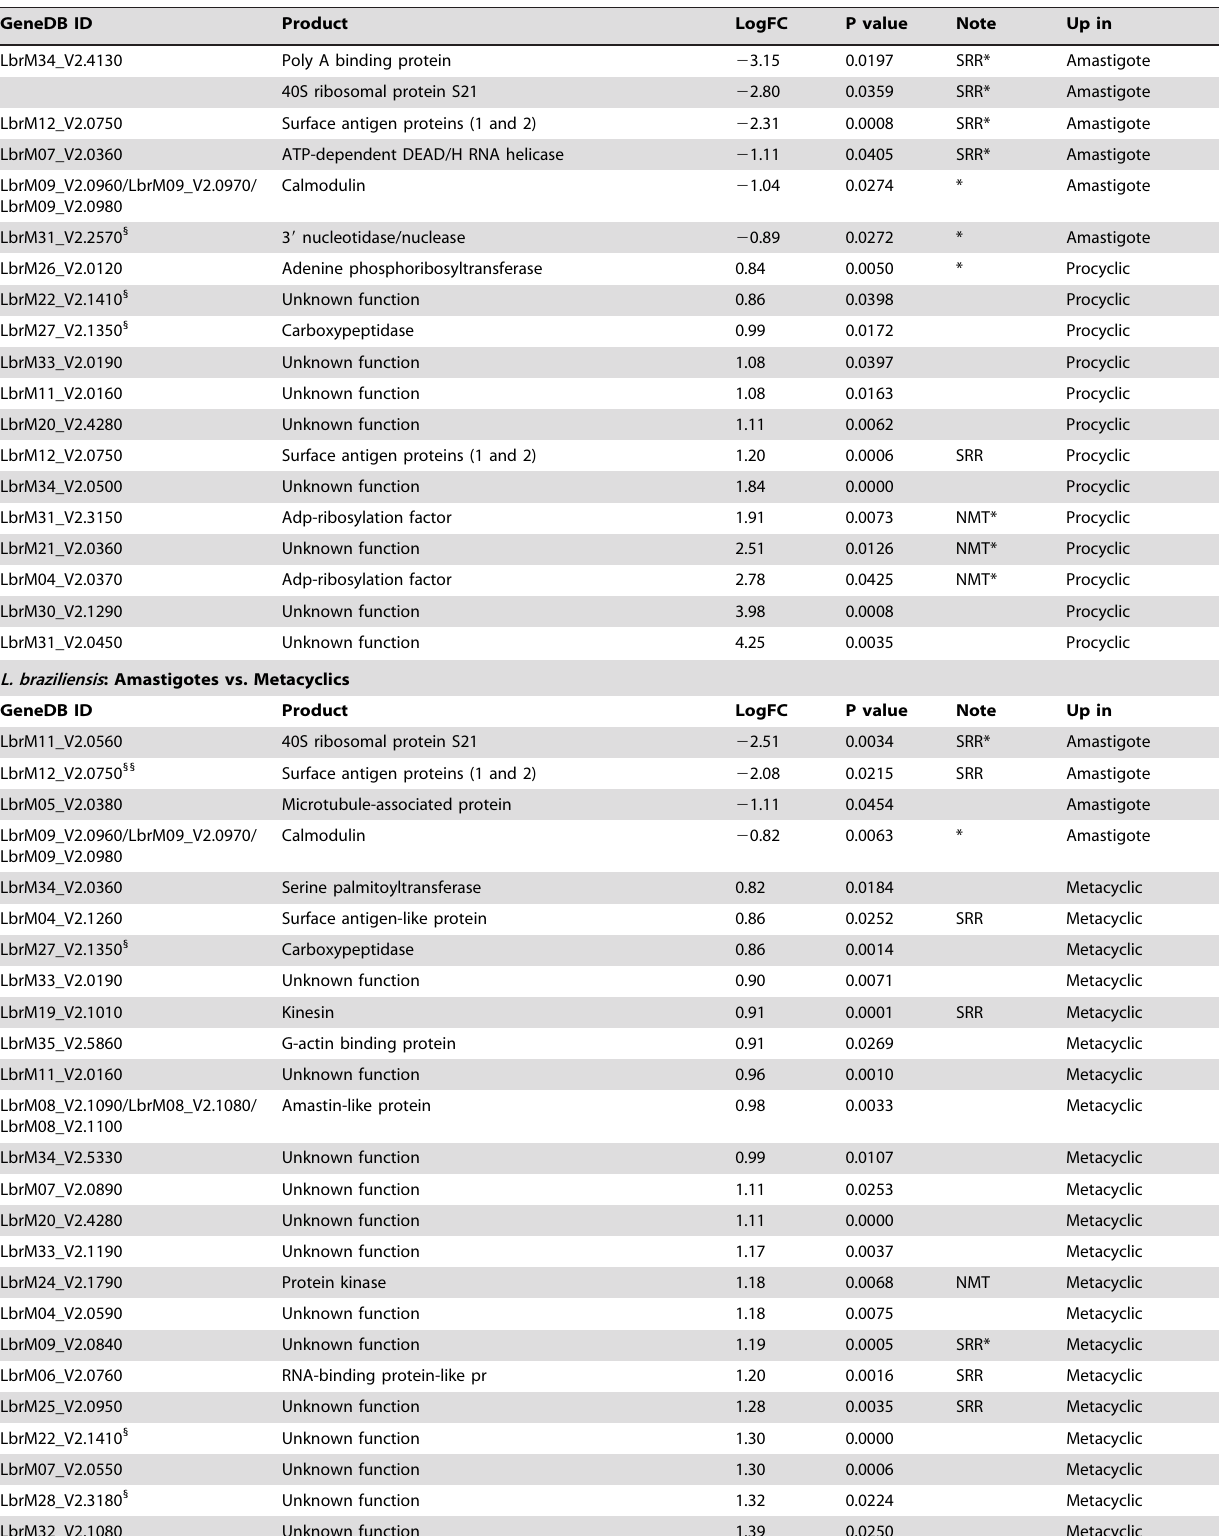
L.braziliensis : Amastigotes vs. Procyclics